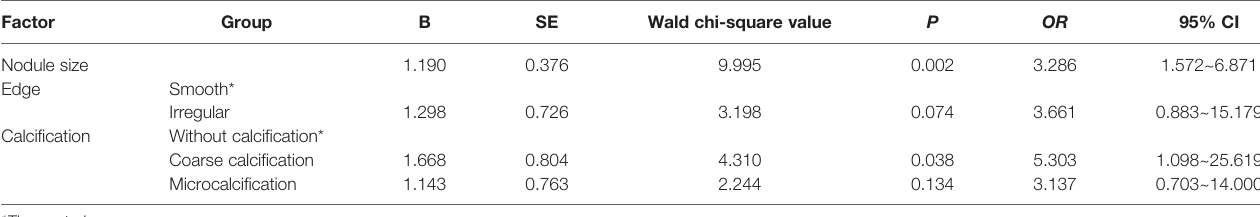
TABLE 5 | Multivariate logistic regression analysis for the SWE false negative results. Factor Nodule size Edge Smooth*